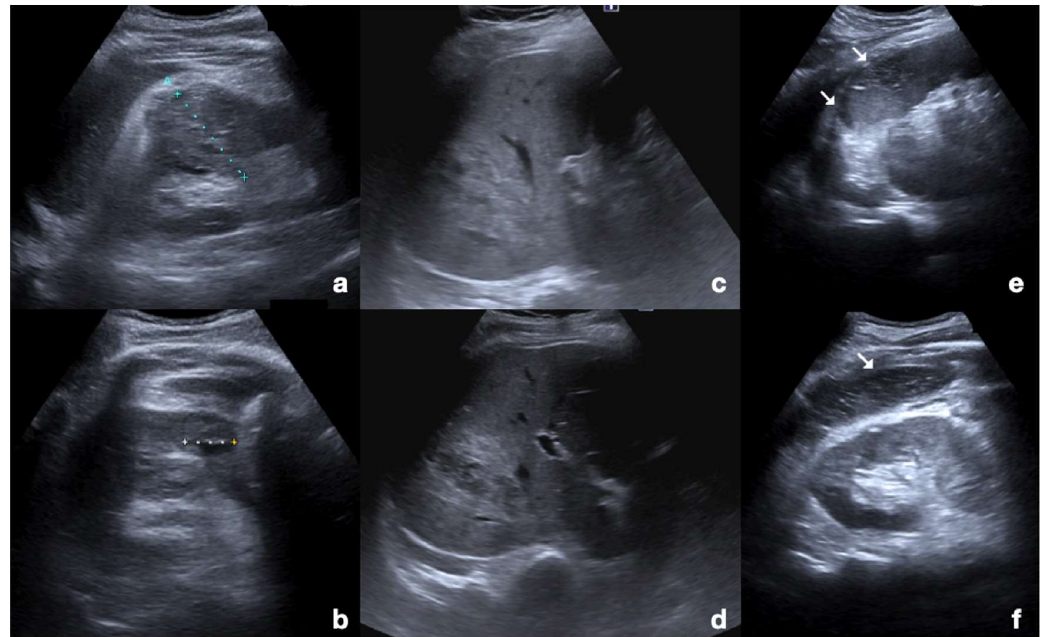
Figure 1. Non-enhanced US of parenchymal injuries. ( a ) Longitudinal view of the right kidney adequate to appreciate the renal parenchymal hematoma in its whole extension; ( b ) axial view of the same kidney showing another smaller hematoma. ( c , d ) Axial views of the liver showing a wide lacero-contusive area in the right lobe (arrows). ( e , f ) Multiple lacero-contusive areas of the spleen (arrows).